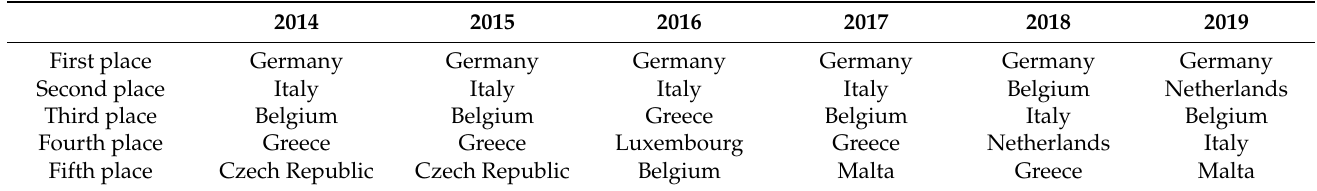
Table 7. European Union countries with maximum photovoltaic capacity per inhabitant in years 2014–2019.